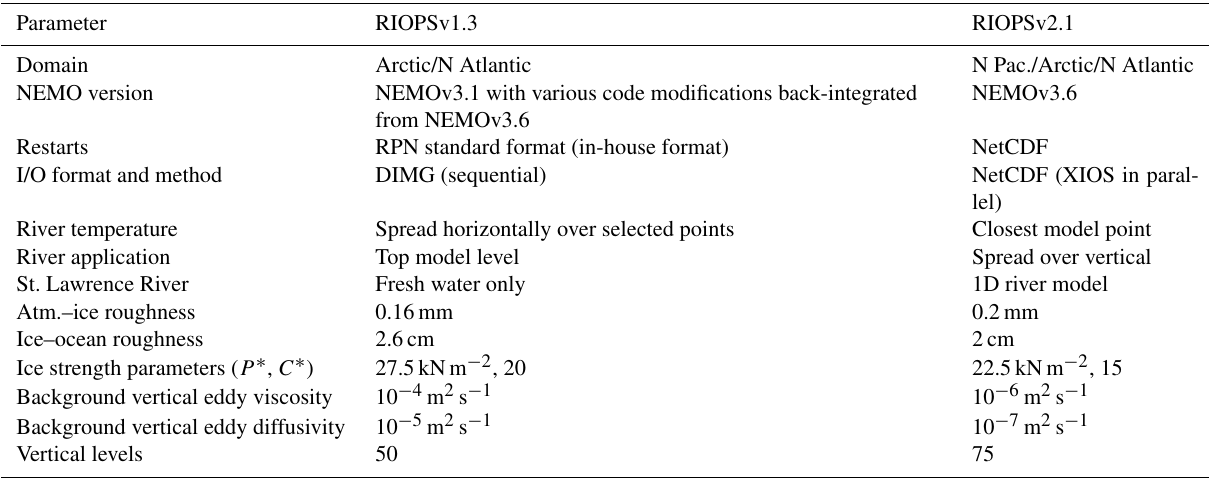
Table 1. Changes to model parameters between RIOPSv1.3 and RIOPSv2.1.